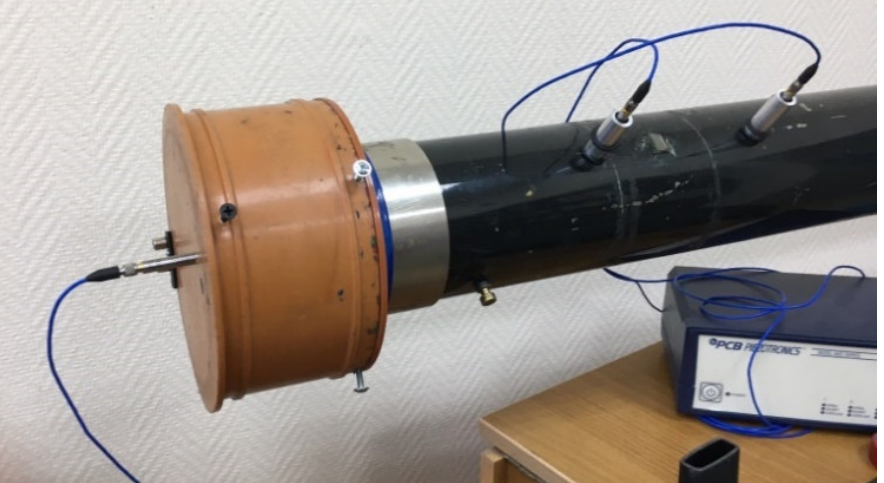
Figure 5. View of the measuring setup with an end resonator Helmholtz and three measuring mi- crophones.